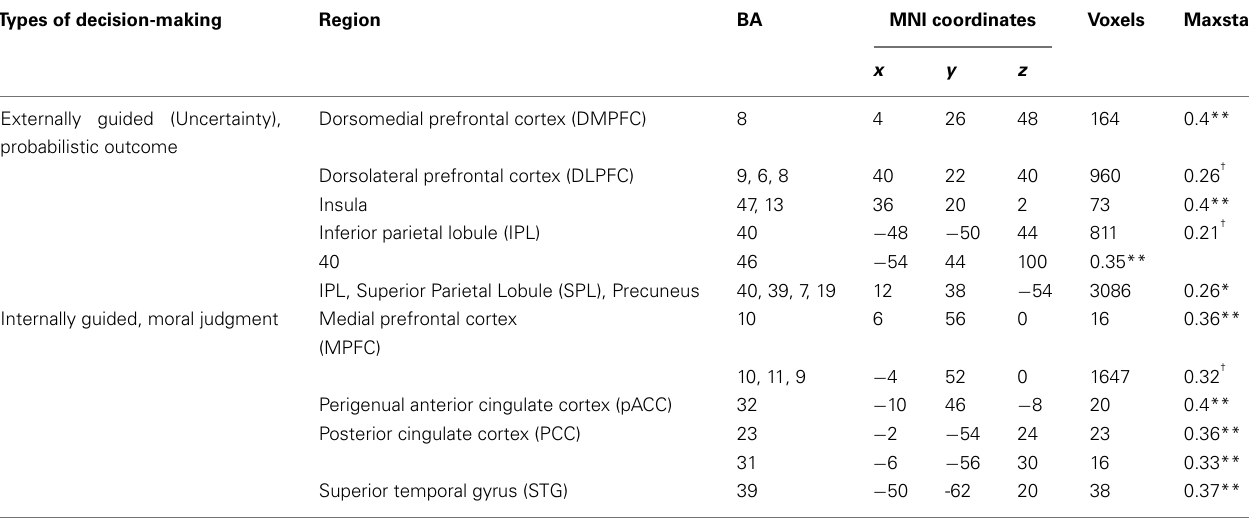
Table 4 | MKDA results for each sub-type of decision-making study Types of